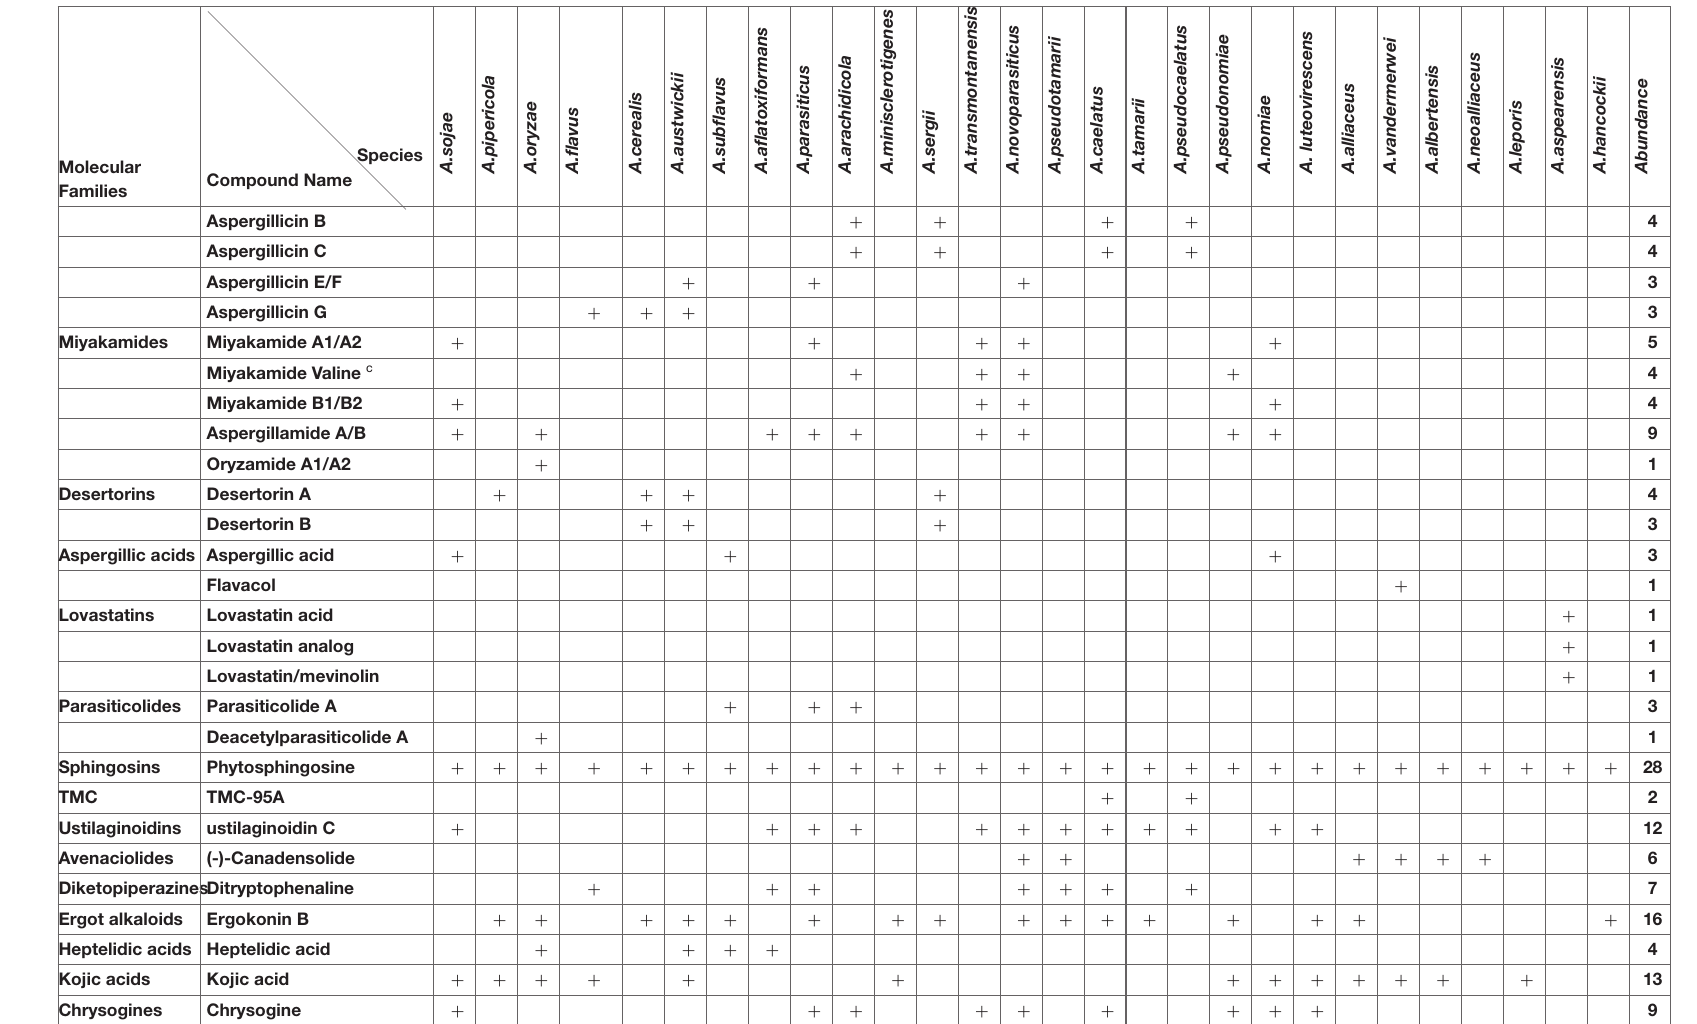
The rows indicate the known metabolites found in this study and the columns indicate the name of species. Abundance indicates the number of species producing the compound in this study. a OMST: O-methylsterigmatocystin. b CPA: Cyclopiazonic acid. c Miyakamide Valine: Miyakamide analogs with